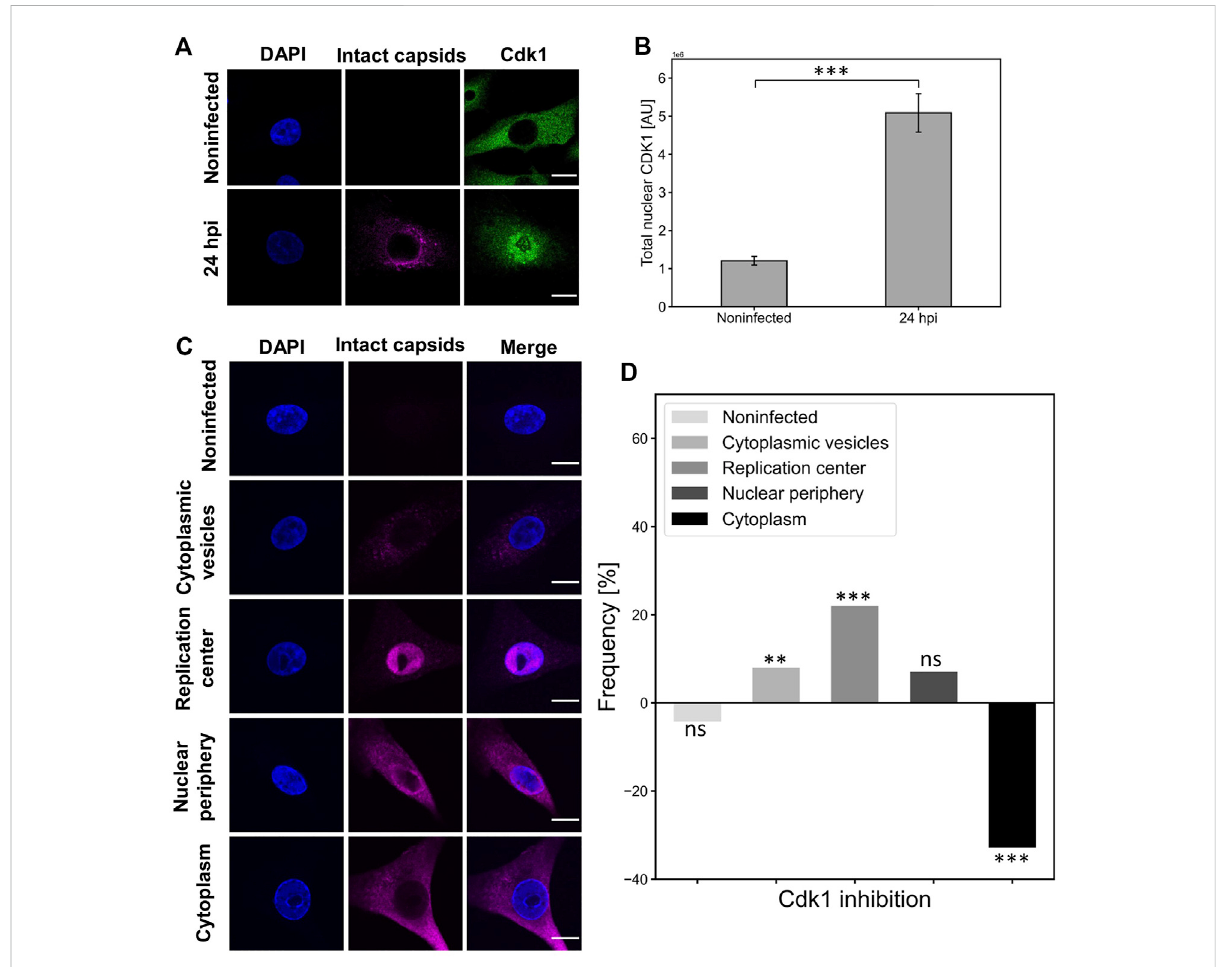
FIGURE 6 Cdk1 is accumulated into the nucleus in infection and its inactivation decreases the nuclear egress of capsids. (A) Representative confocal images show the distribution of capsids (magenta) and Cdk1 (green) in NLFK cells at 24 hpi. The cells were immunolabeled with antibodies against intact capsids and Cdk1, and blue corresponds to DAPI staining. Scale bars, 10 µm. (B) Total nuclear fl uorescence intensities of antibody-labeled Cdk1 in non-infected and infected cells ( n = 28). Statistical signi fi cances were determined using Student´s t -test. Signi fi cant differences are denoted as *** ( p < 0.001). The error bars show the standard error of the mean (SEM). (C) The intracellular variation in the cellular distribution of capsidsat24 hpi.Fivecapsidlocalizationclassesareshown:non-infected,cytoplasmicvesicles,replicationcenter,nuclearperipheryandcytoplasm (nuclear periphery), and cytoplasm. The cells were immunolabeled with antibodies against intact capsids (magenta) and blue corresponds to DAPI staining. Scale bars, 10 µm. (D) The effect of Cdk1 inhibitor RO3306 treatment on the incidence of capsid distribution classes. The horizontal line at value 0 represents capsid distribution in untreated infected cells at 24 hpi, and positive and negative values represent treatment-induced increase anddecreaseinthefrequencyofthecapsiddistribution classes.Signi fi cantdifferencestestedwiththechi-squaretestaredenotedas***( p <